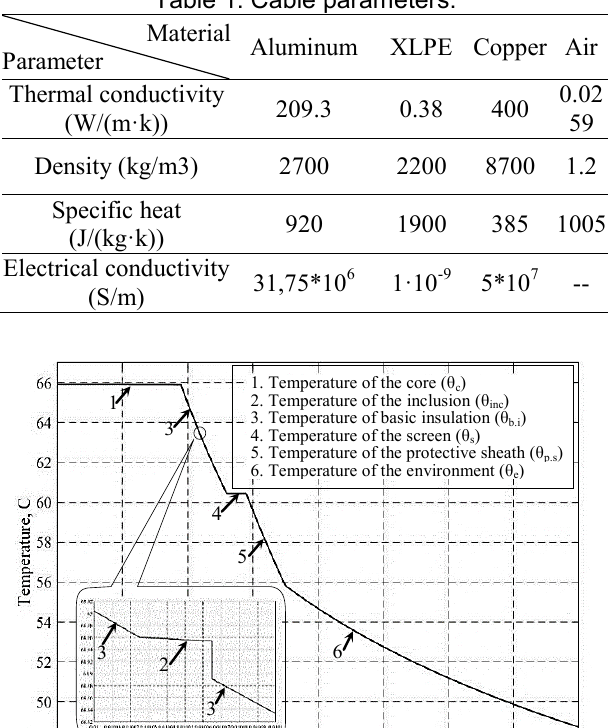
relation to the core